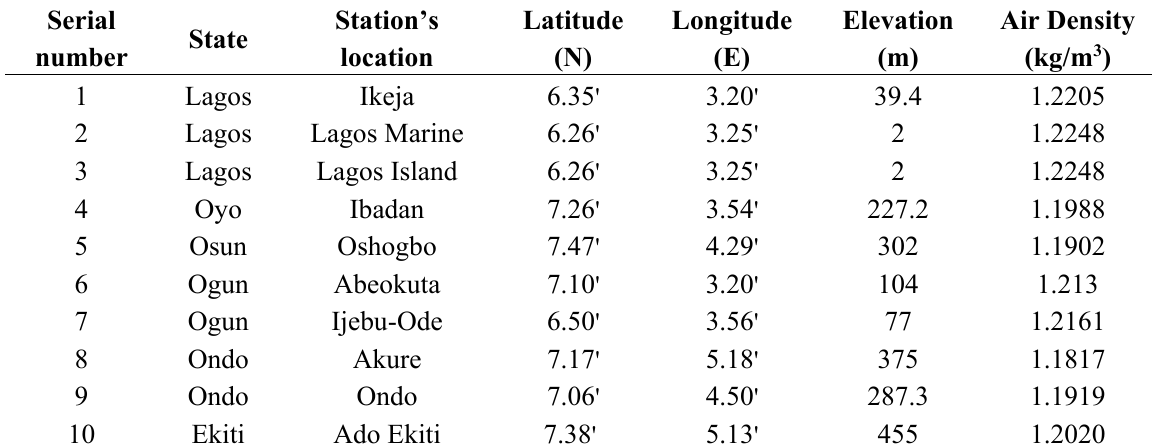
Table 1. Location information for the Nigeria Meteorological (NIMET) stations.